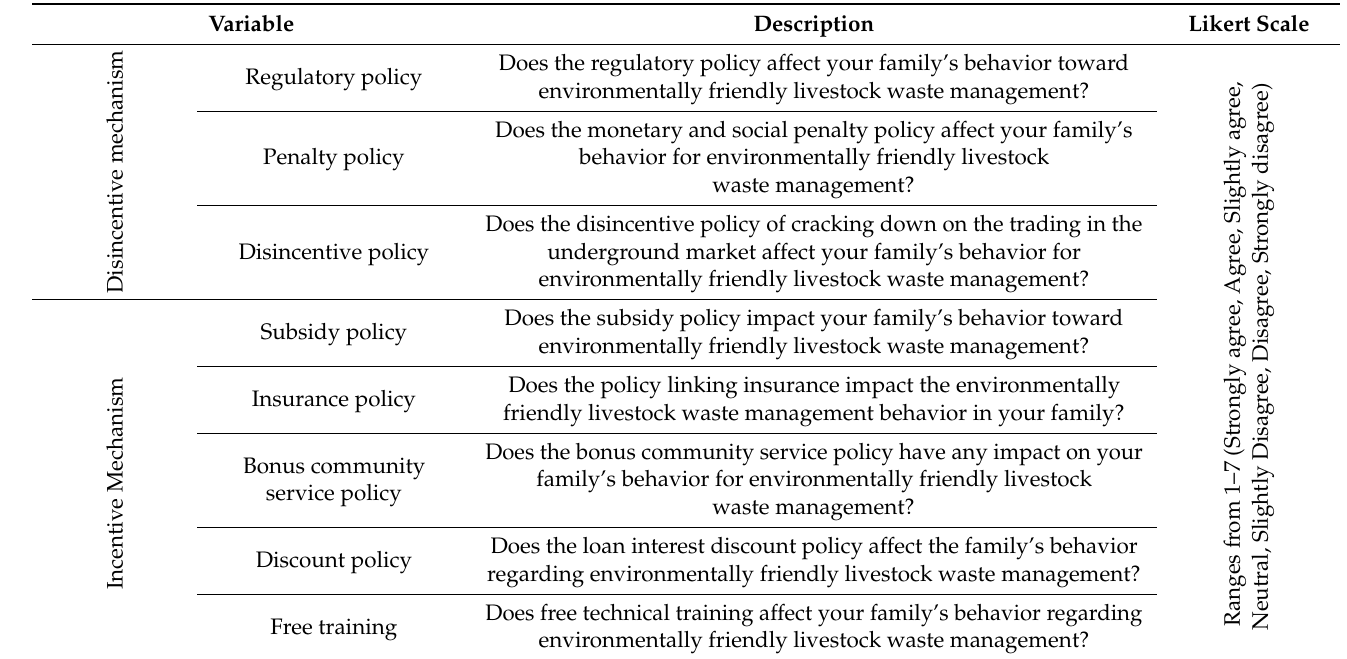
Table 1. Selected